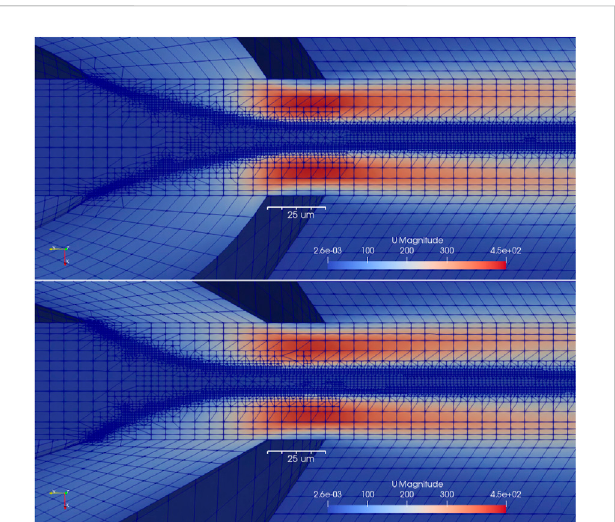
FIGURE 22 Streamlinesofthegas fl owandtheliquid fl owforthe3Dsimulation ofthecone-shapedandthebell-shapednozzledesigns.Thestreamlines are visualized by a noise function motion blurred in the direction of the velocity with the contours representing the magnitude of the